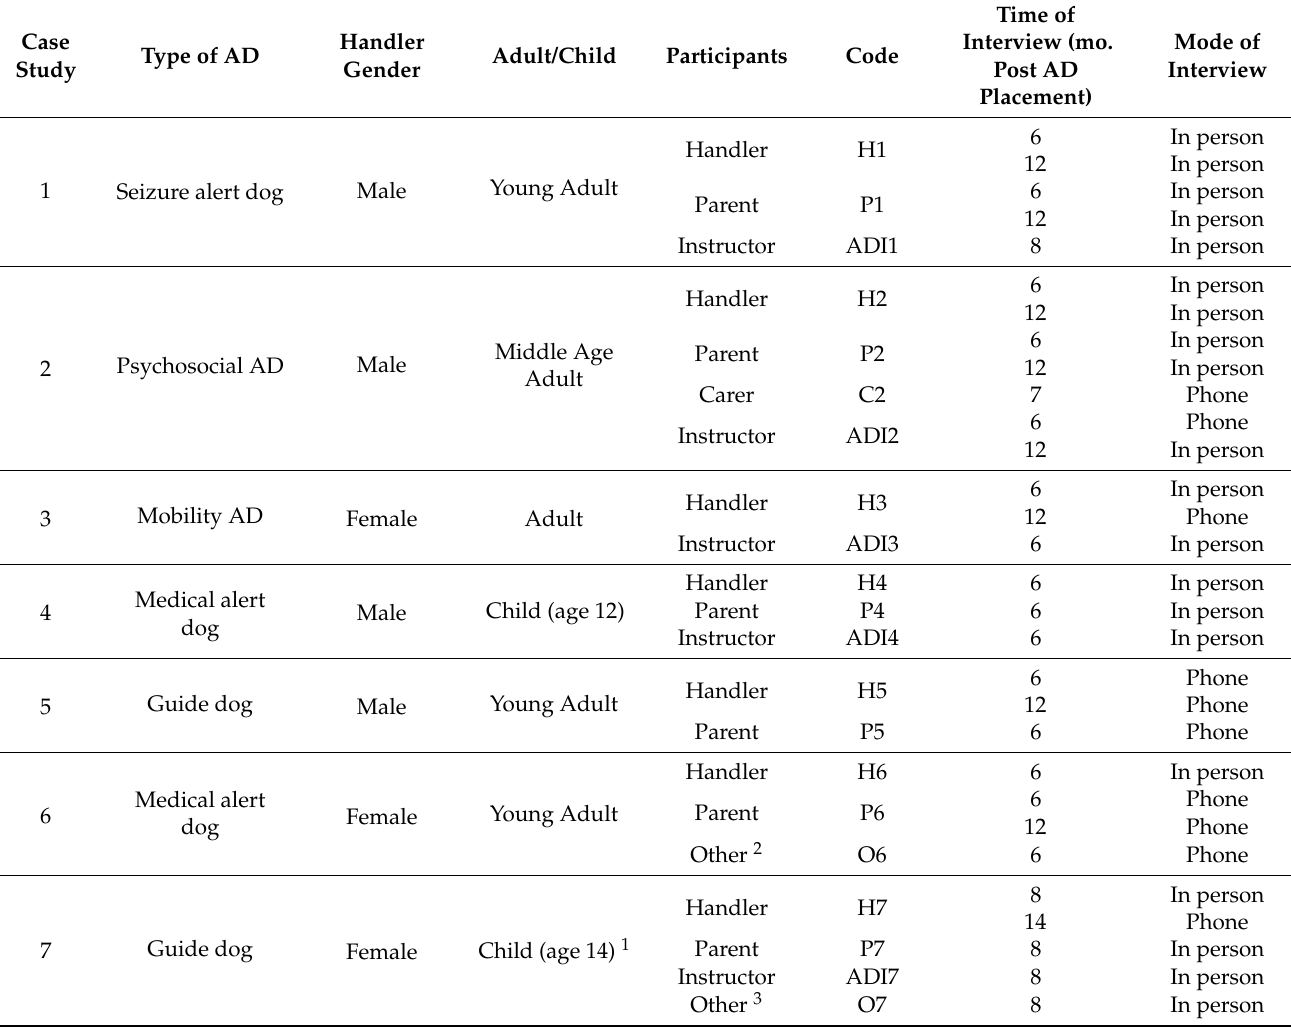
Table 1. Demographic information for case study